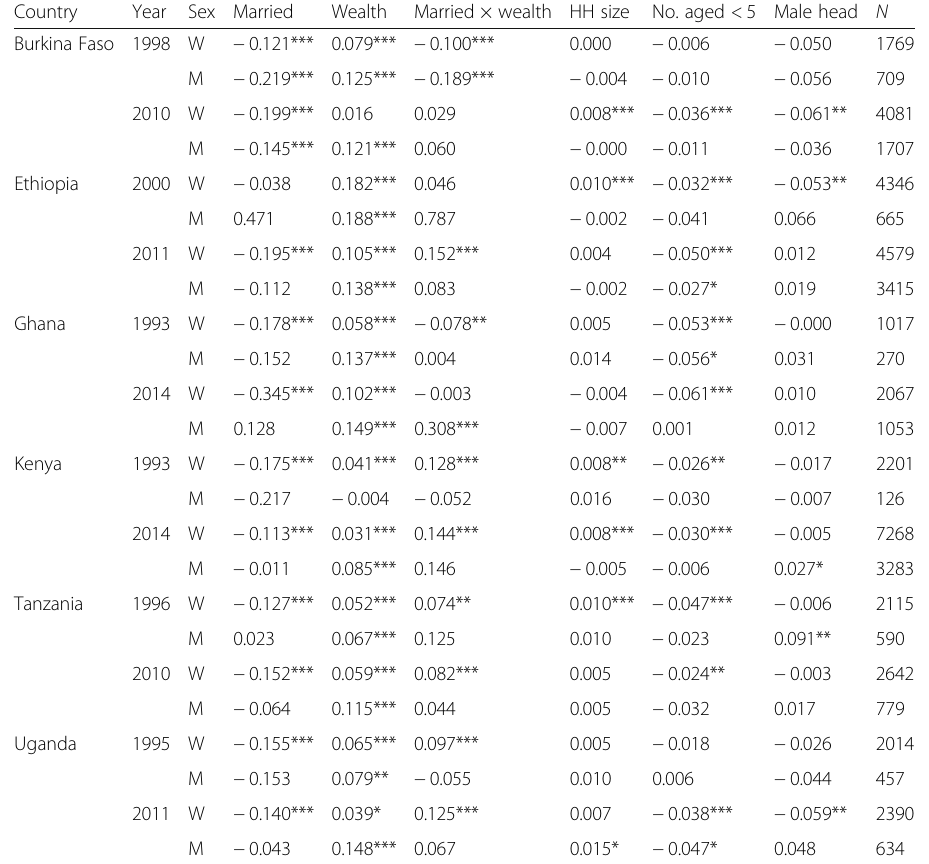
Table 10 Selected LPM regression coefficients: dependent variable: passes a literacy test